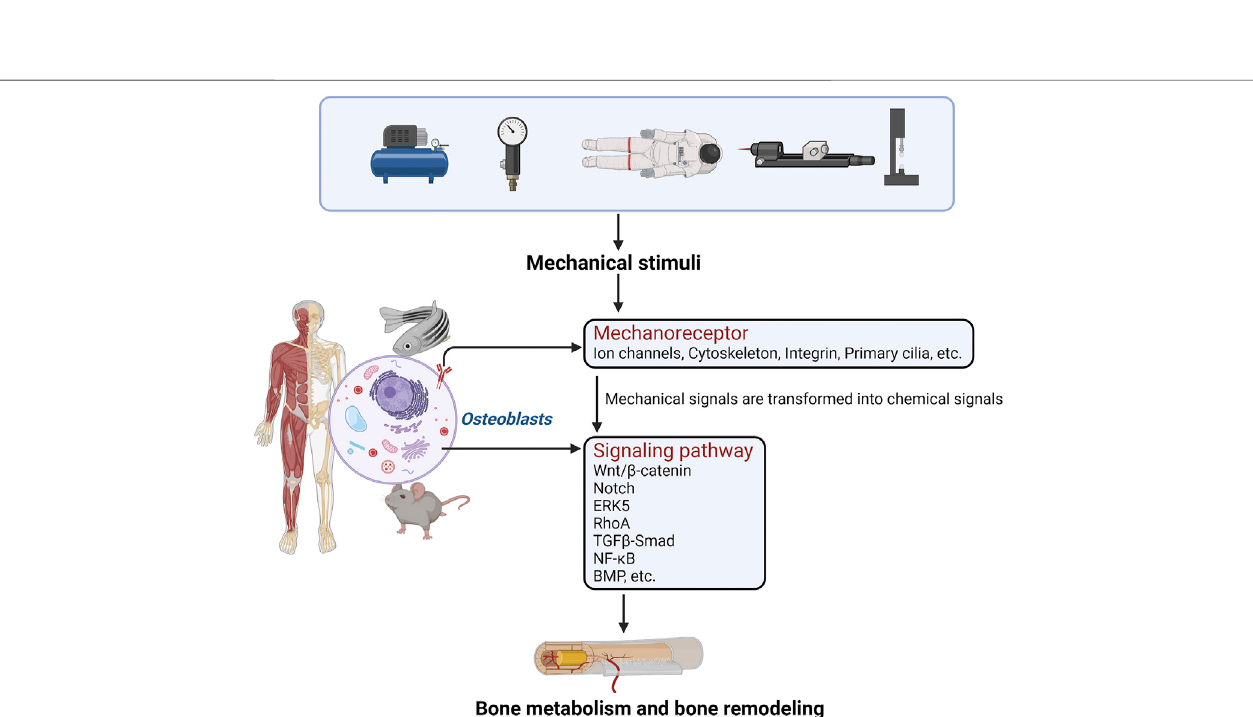
FIGURE 1 | The perception of mechanical stress by osteoblasts fi rst involves actions on mechanoreceptors through various pathways. Mechanoreceptors also regulate the expression of corresponding genes to convert mechanical stimulus signals into chemical stimuli, and regulate the relevant signal transduction pathways. Finally, bone metabolism and bone formation are